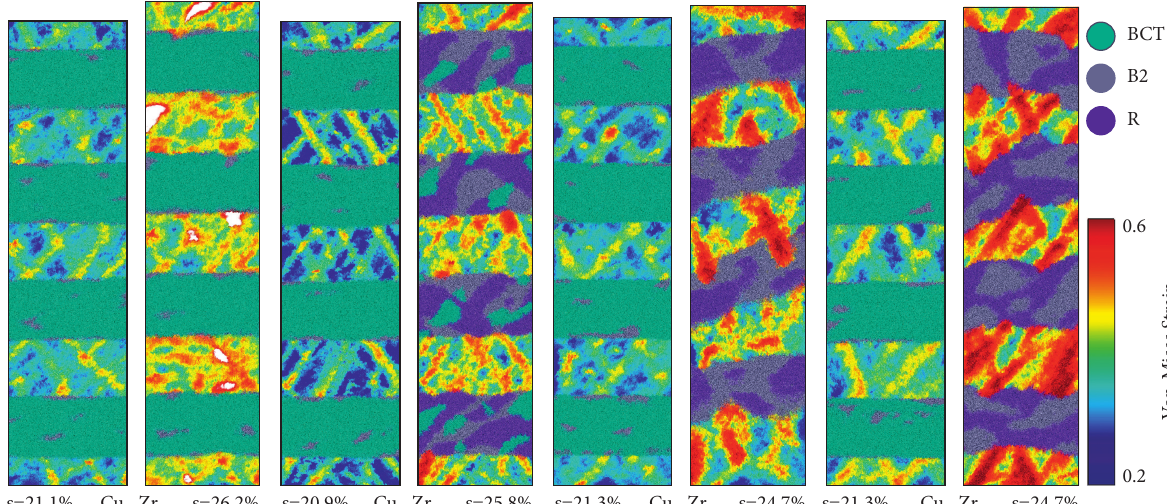
Figure 5: The atomic configurations of the composites at the end stage of tensile